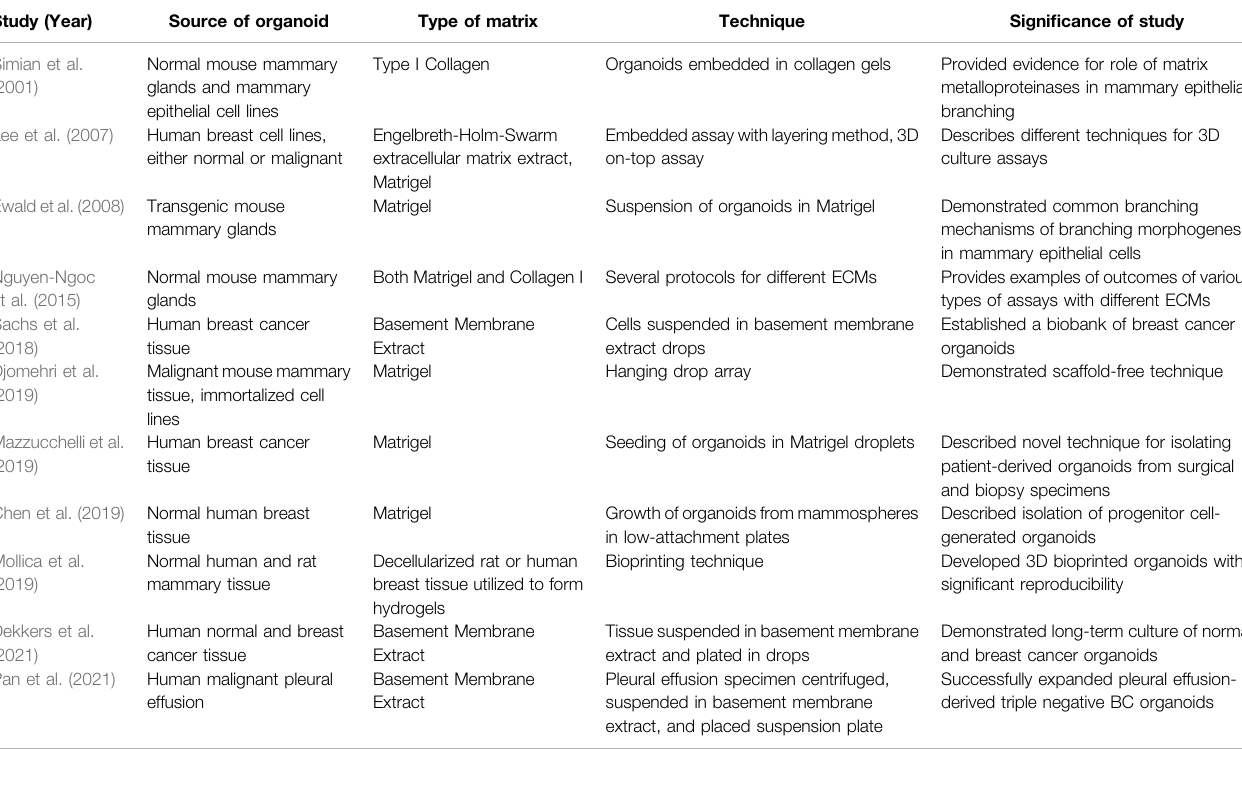
TABLE 1 | Signi fi cant mammary organoid studies with associated protocol details.